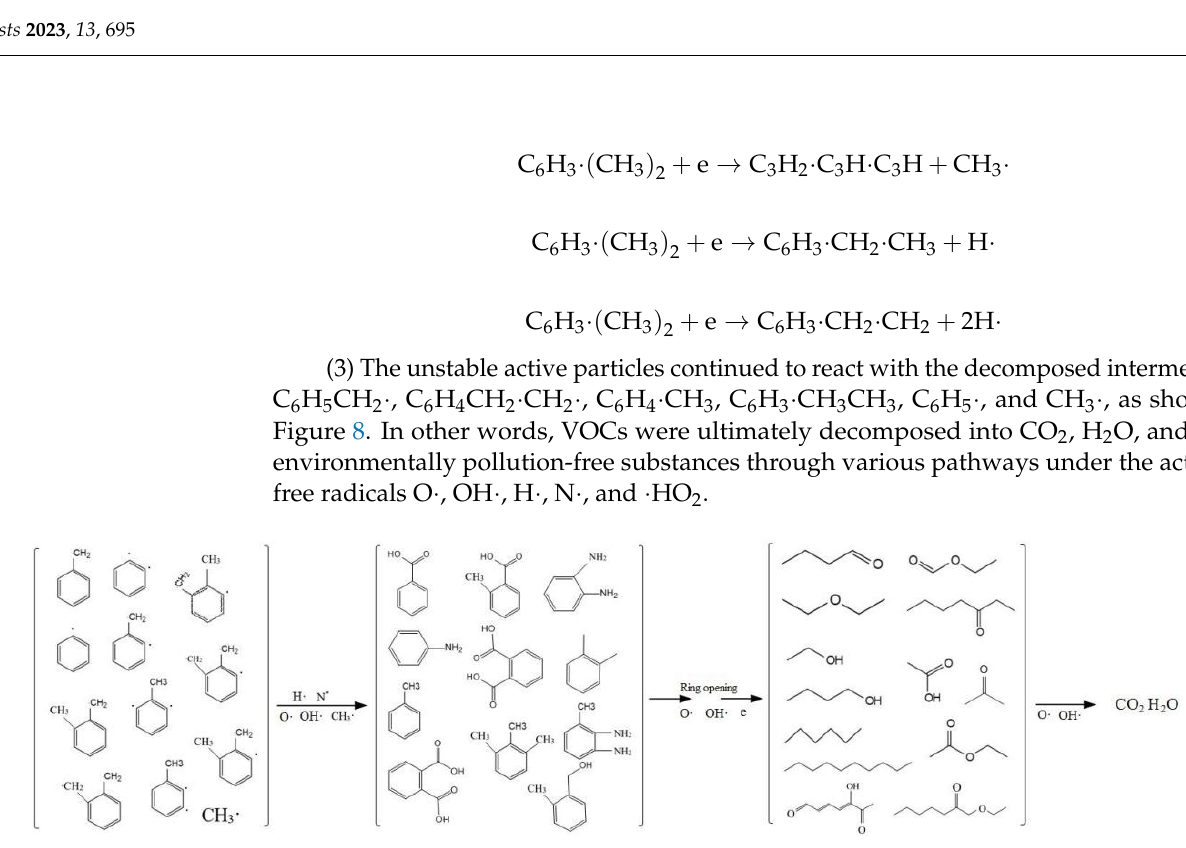
Table 2. The reaction of breaking different chemical bonds in toluene and o-xylene [56]. Chemical Bonds Energy/eV Bond Breaking Reactions that Occurred after Collision